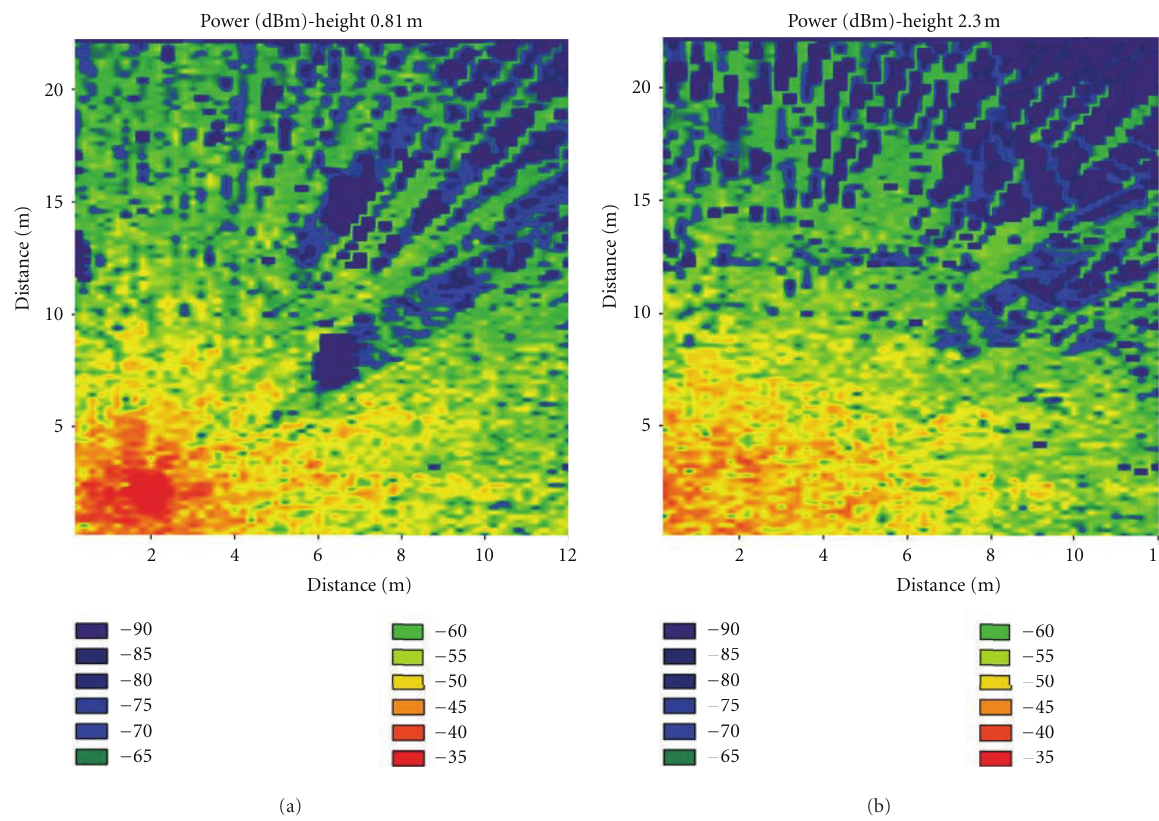
Figure 14: Spatial distribution of received power (dBm) for di ff erent heights in the indoor scenario of Figure 2(b) with the 3D ray launching